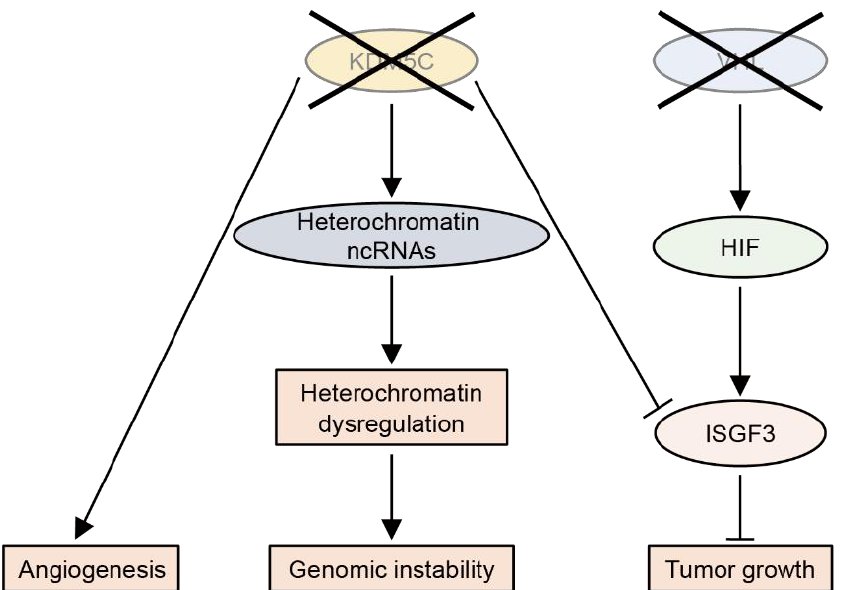
Figure 5. The loss-of-function of KDM5C promotes clear cell renal cell carcinoma (ccRCC). The loss-of-function of KDM5C increases genomic instability in ccRCC by heterochromatin dysregulation through the upregulation of non-coding (nc)RNAs. KDM5C deficiency also promotes angiogenesis. In VHL-deficient ccRCC cells, KDM5C deficiency promotes tumor growth by suppressing the tumor suppressor ISGF3, which is induced by